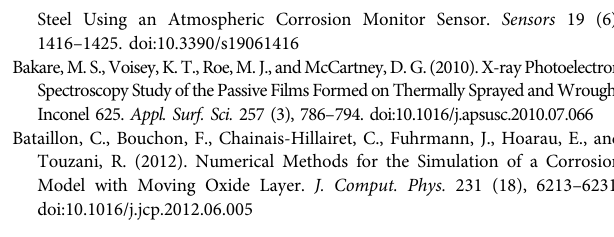
Frontiers in Materials |